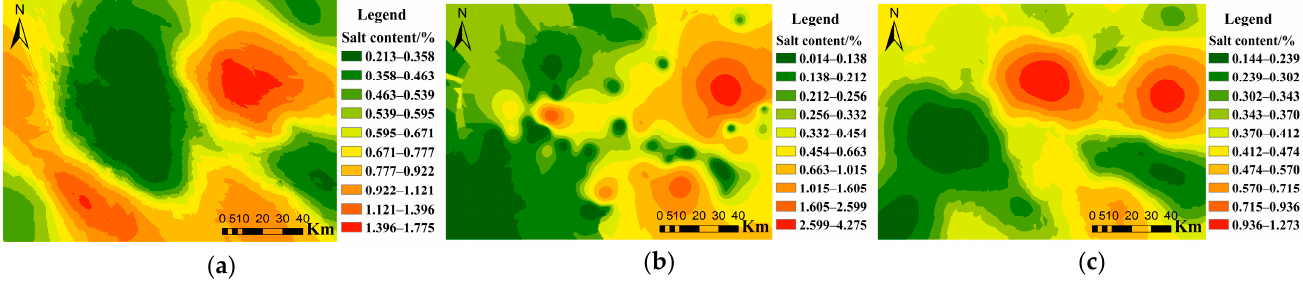
Figure 7. Spatial distribution of soil salt content at different depths: spatial distribution of soil salinity in the layers between 0 m and 0.25 m ( a ); spatial distribution of soil salinity in the layers between 1 m and 2 m ( b ); spatial distribution of soil salinity in the layers between 2 m and 3 m ( c ). Table 5. Comparison of interpolation accuracy in different